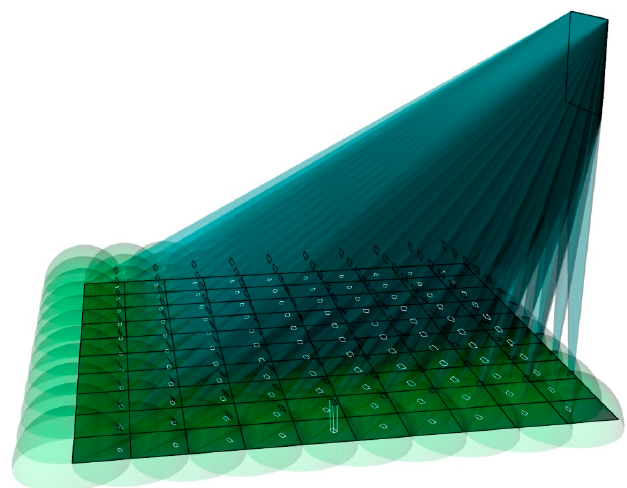
Figure 10. Visualization of the intersections between the ‘radiant cones’ and the unit spheres and their corresponding projections on the chosen